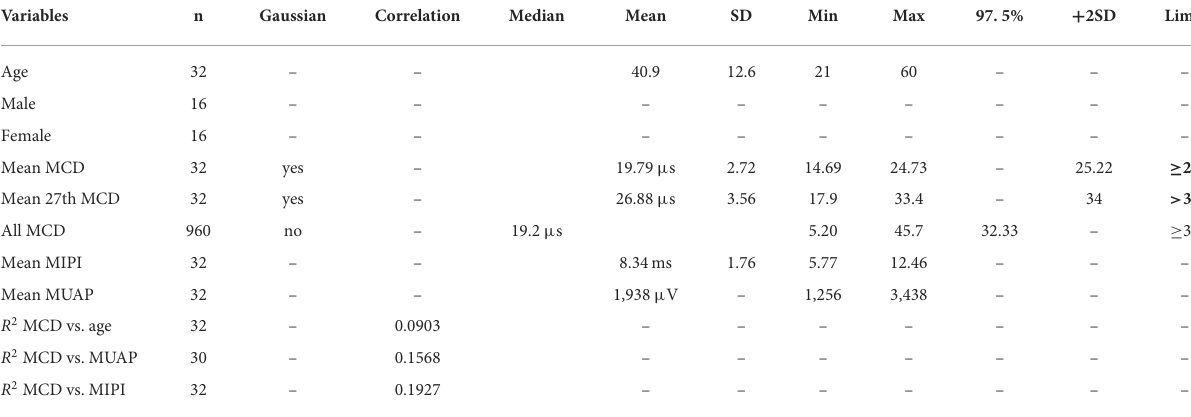
TABLE 1 Data from the CNE reference s-jitter parameters for the Tibialis Anterior muscle in 32 subjects. Variables n Gaussian Correlation